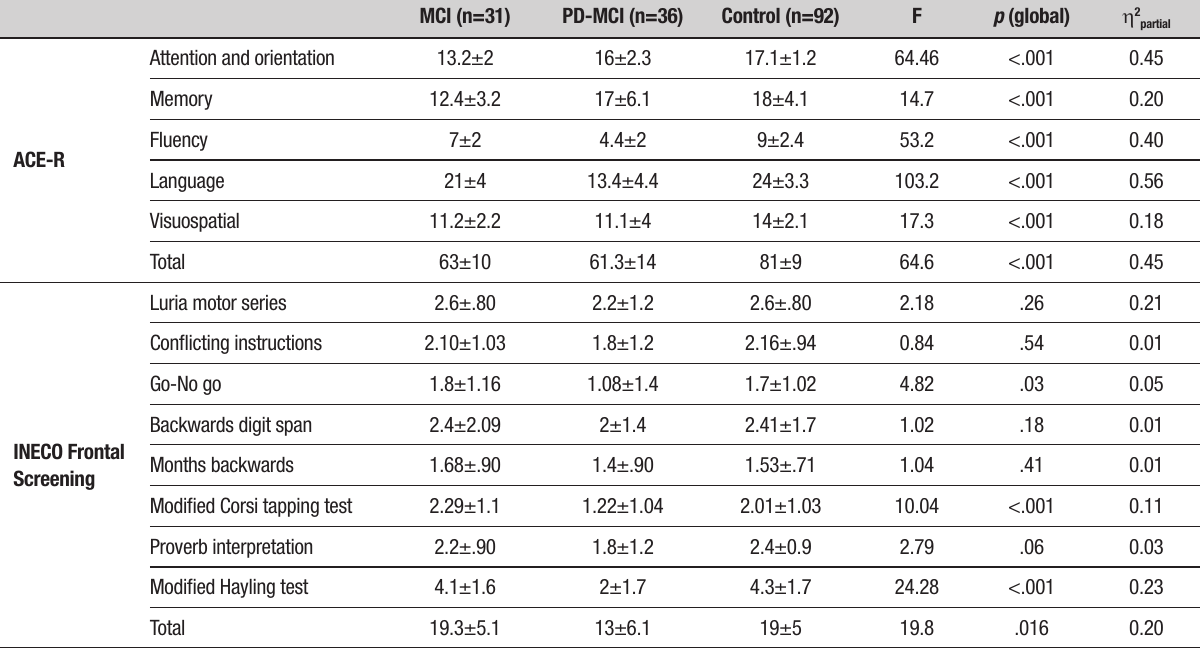
Table 3. Scores on the MMSE, ACE-R (total score and sub-scores), INECO Frontal Screening (total score and sub-scores) in PD-MCI, MCI, and control groups.